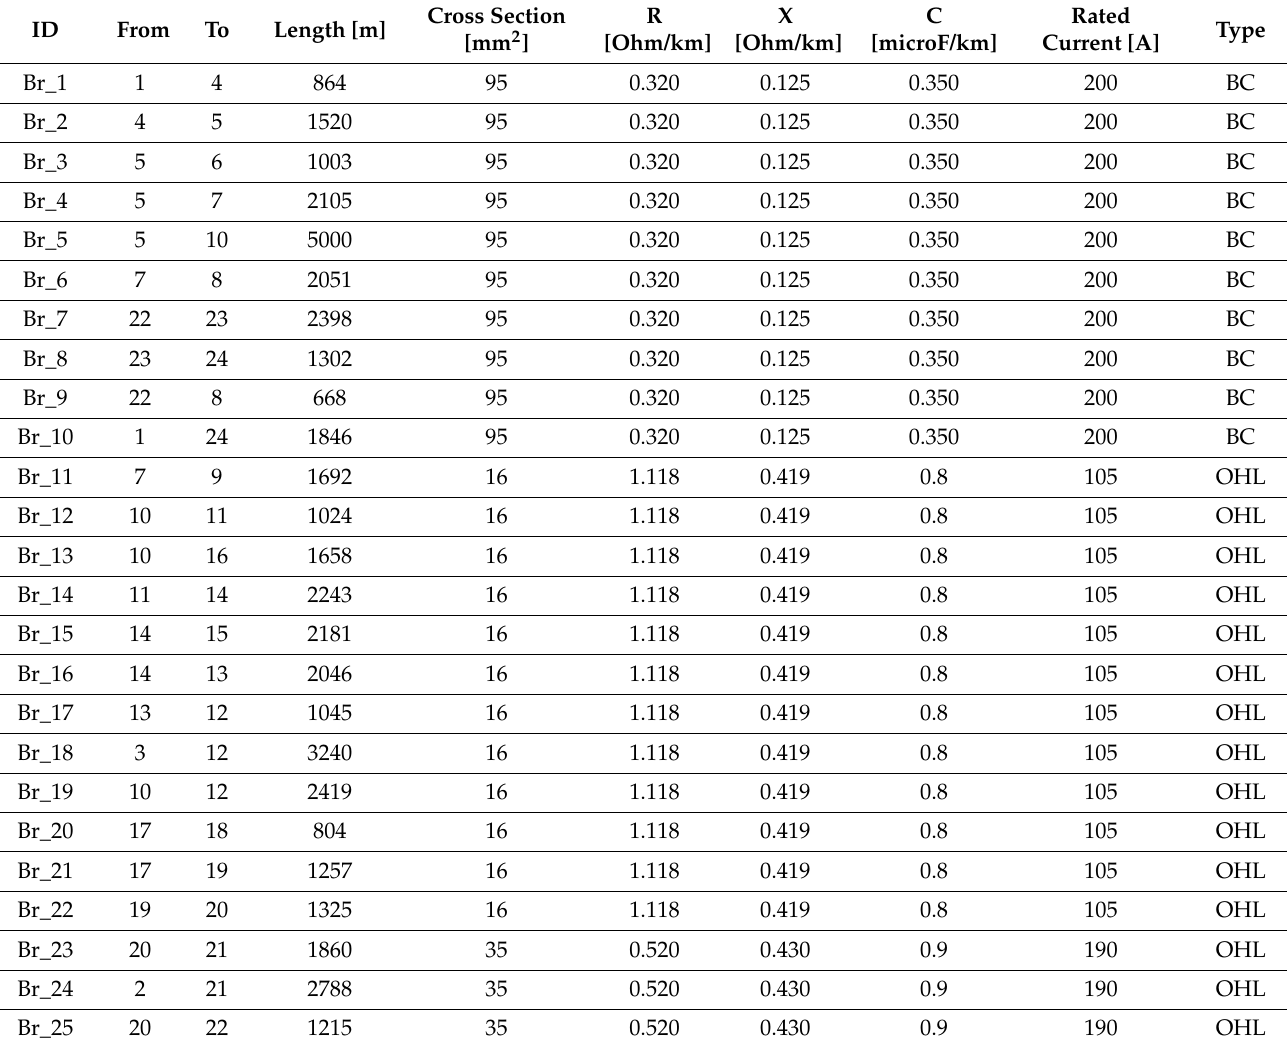
Table A1. Main parameters of the line of the studied